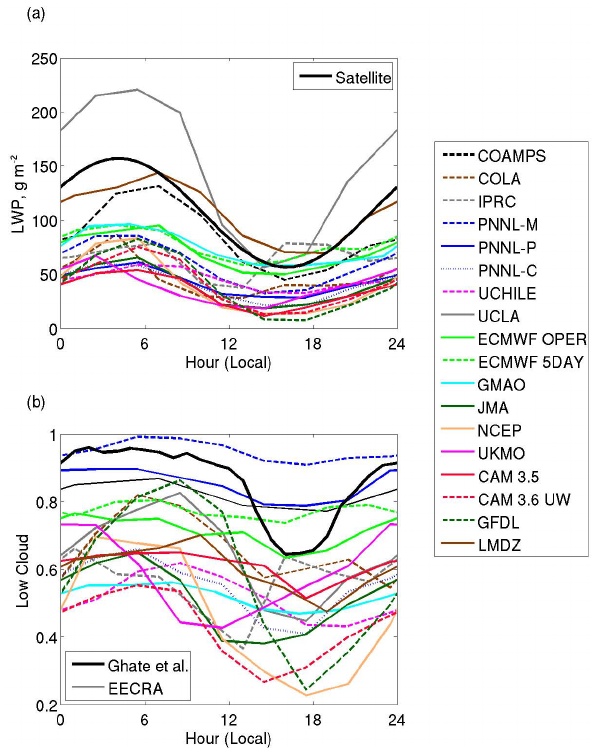
Fig. 11. Composite October 2006 diurnal cycle of (a) liquid water path (gm − 2 ) and (b) low cloud fraction at the IMET buoy at 85 ◦ W 20 ◦ S. In (a) satellite observations from 2006 (see text) are plotted (thick black line) and in (b) observed climatologies of cloud fraction from the buoy (Ghate et al., 2009, thick black line) and EECRA (Hahn and Warren, 1999, thin black line) are